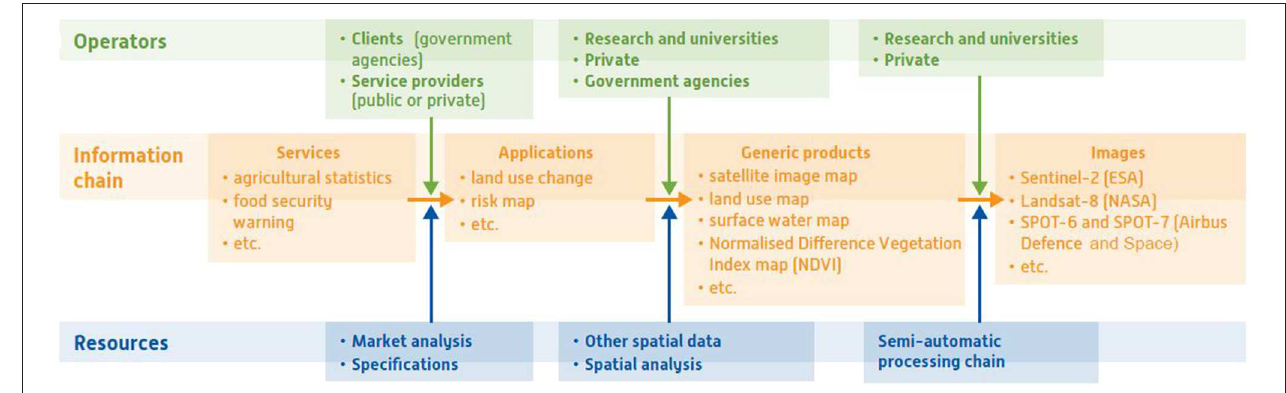
FIGURE 1 | The co-construction of geospatial information services based on EO data (source: Tonneau et al.,